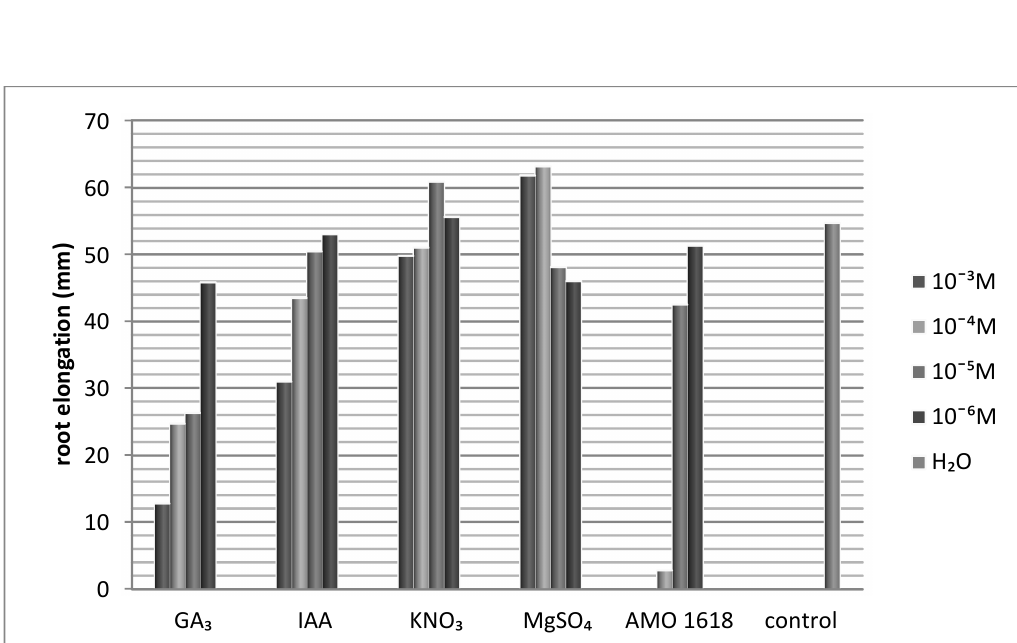
Figure 1. Effect of different plant growth regulators and inhibitor AMO 1618 on T. aestivum root